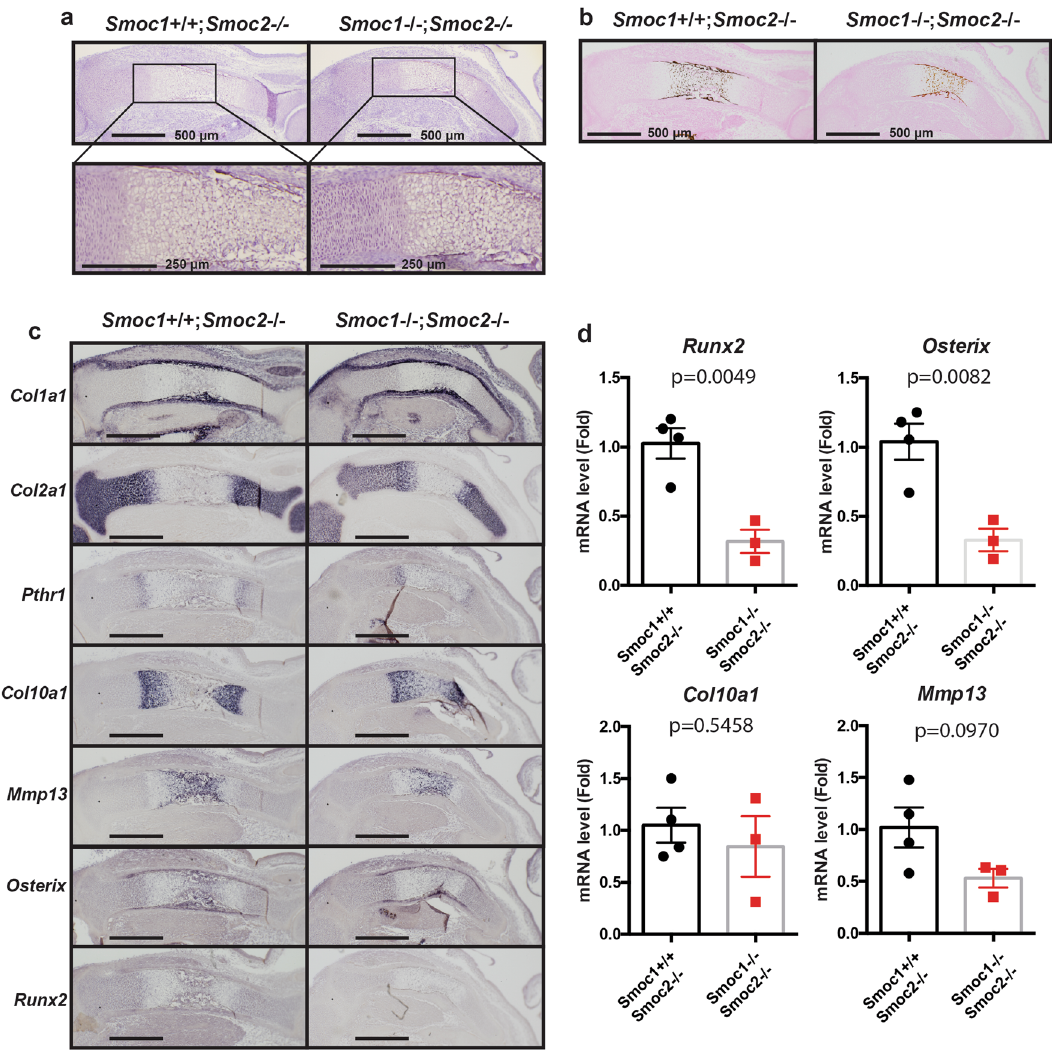
Fig. 5 Delayed endochondral bone formation in Smoc1/2 DKO mice. Smoc1 + / − ; Smoc2 − / − mice were mated, and Smoc1 + / + ; Smoc2 − / − and Smoc1 − / − ; Smoc2 − / − littermate mice at E15.5 were examined by hematoxylin-eosin ( a ) and von Kossa ( b ) staining ( n = 4). c In situ hybridization analyses using antisense probes against Col1a1 , Col2a1 , Pthr1 , Col10a1 , Mmp13 , Osterix , and Runx2 . Scale bars: 500 μ m ( n = 4, biologically independent animals). d The total RNA was extracted from the tibia of Smoc1 + / + ; Smoc2 − / − or Smoc1 − / − ; Smoc2 − / − littermate mice at E15.5. The Runx2 , Osterix , Col10a1 , and Mmp13 expression levels were determined by RT-qPCR ( Smoc1 + / + ; Smoc2 − / − : n = 4, Smoc1 − / − ; Smoc2 − / − : n = 3, biologically independent animals). Values are the